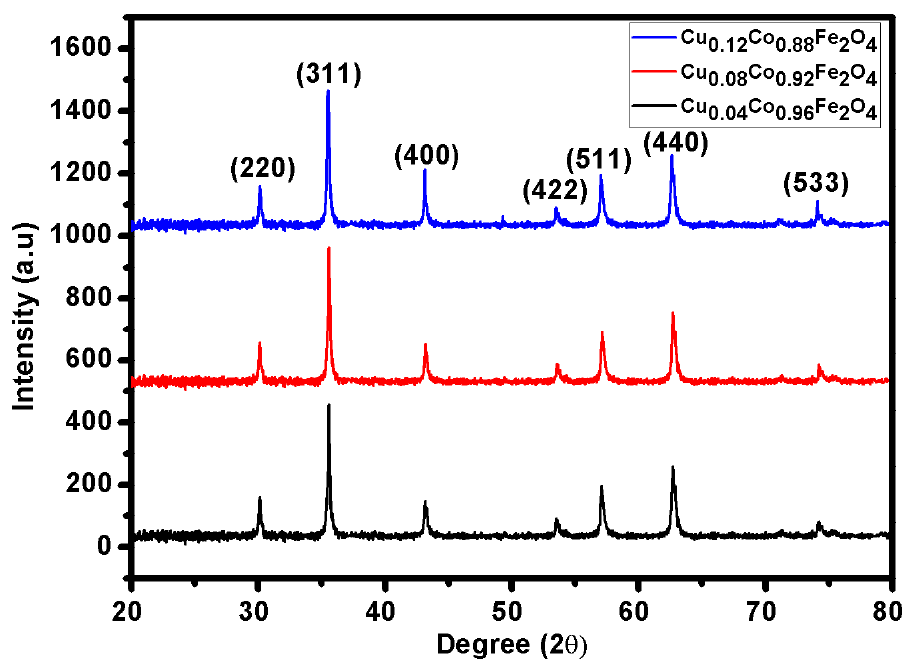
Figure 1. XRD patterns of CFO NPs doped with Cu 2+ ions.